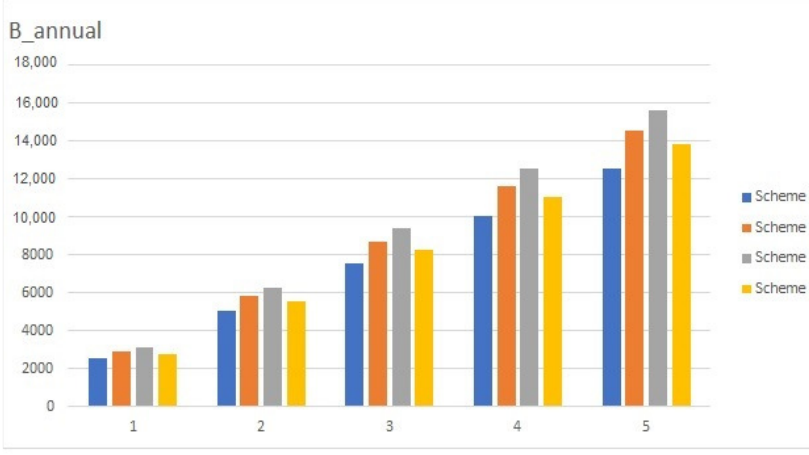
Figure 9. Comparative analysis of Schemes